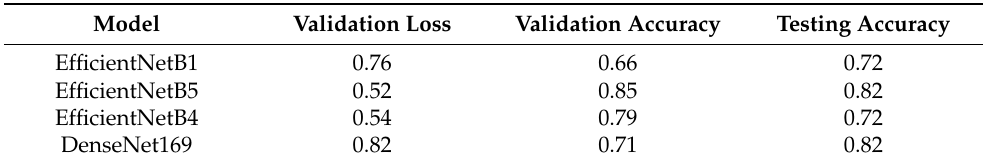
Table 6. Performance of the 4 best pretrained networks for defect classifier after fine tuning for a total of 15